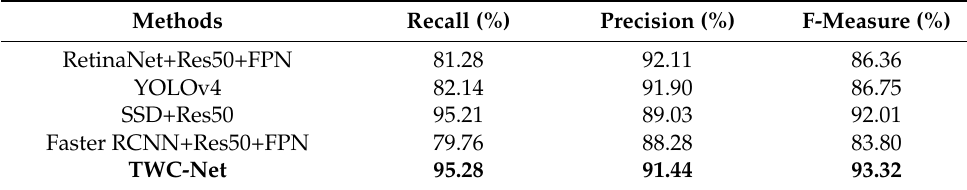
Table 2. Recall, precision, and F-measure of all methods (IOU =